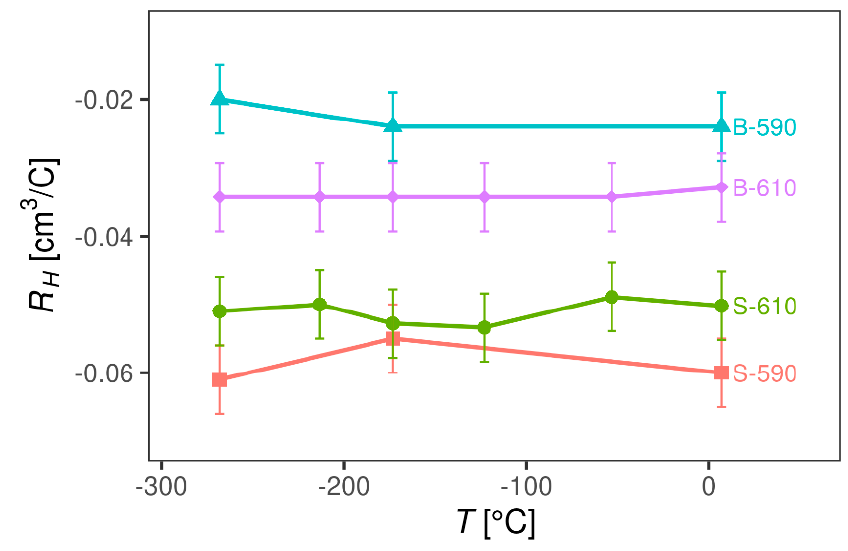
Figure 7. Hall coefficient R H of SnO 2 samples as a function of temperature.